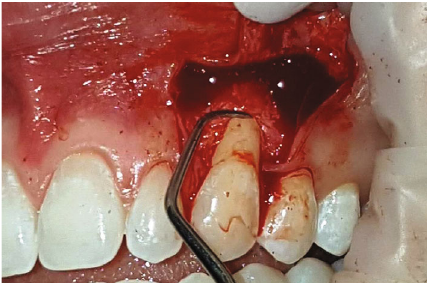
Figure 8: Scaled and planned with 5-6 Gracey curettes in canine root prior to receiving graft of adipose tissue.